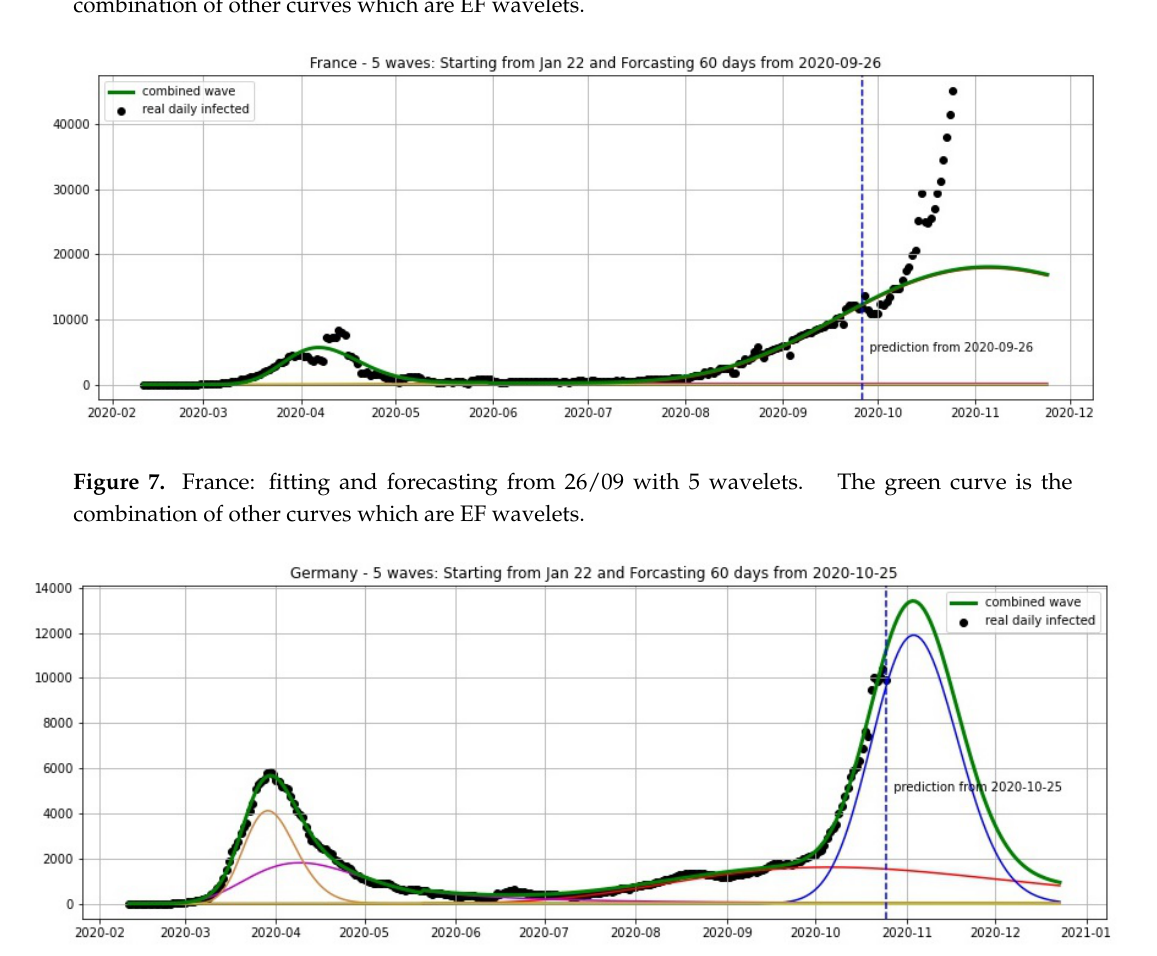
Figure 8. Germany: fitting and forecasting from 25 October with 5 wavelets. The green curve is the combination of other curves which are EF